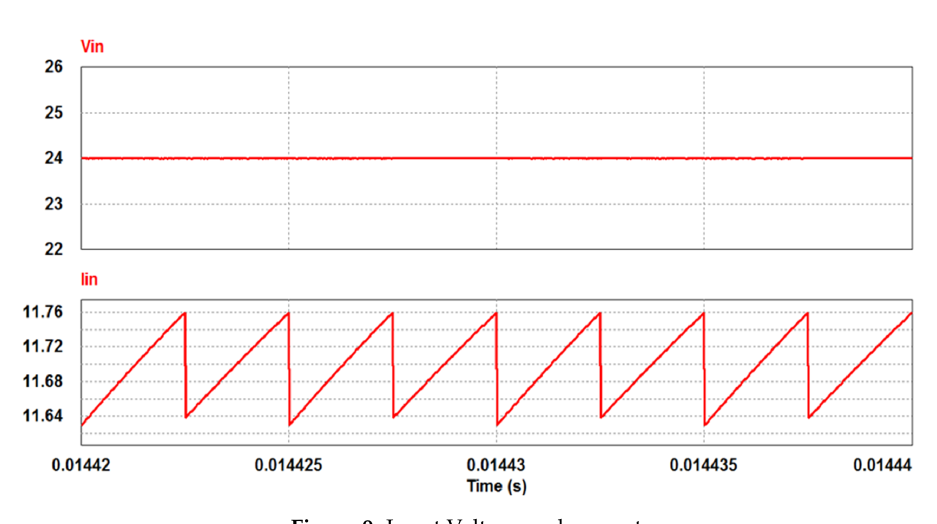
Figure 9. Input Voltage and current.